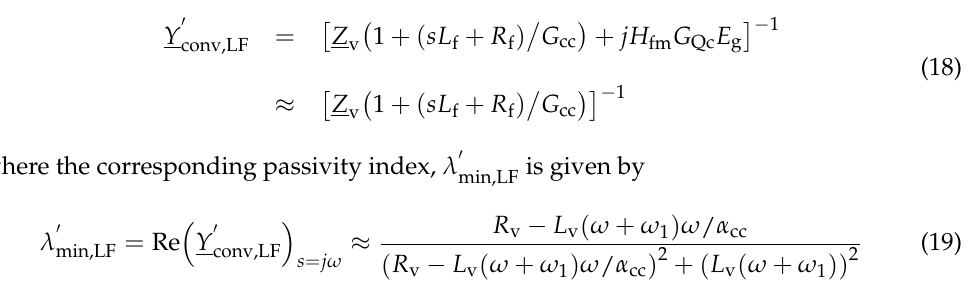
Figure 12. Frequency characteristic of λ (cid:48) L v = 0.2 pu (blue), L v = 0.4 pu (green), and L v = 0.6 pu (red); solid curves represent the case